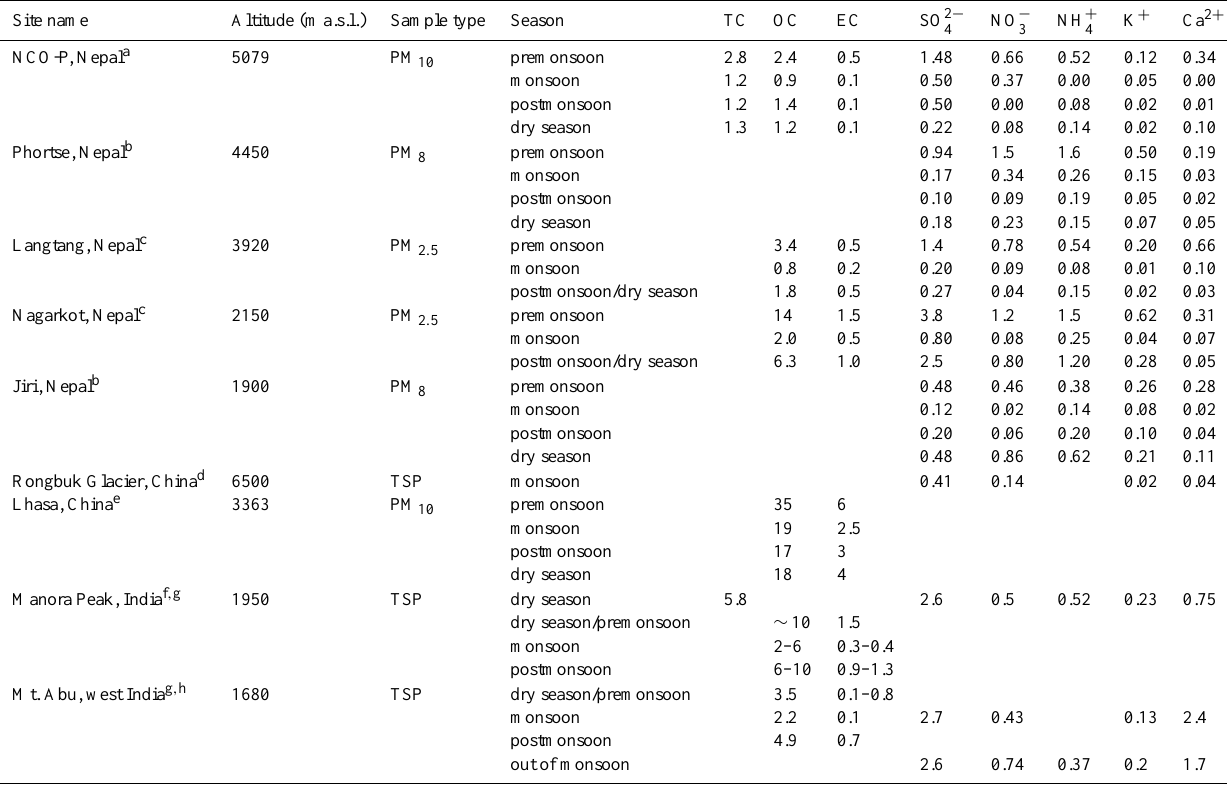
Table 4a. Concentrations of main aerosol chemical species at NCO-P compared to other mountain stations in Nepal, China and India. Data are provided in µg scm − 1 (standard cubic meters). a This study; b Shrestha et al., 2000; c Carrico et al., 2003; d Ming et al., 2007; e Zhang et al., 2008; f Rengarajan et al., 2007; g Ram et al., 2008; h Rastogi and Sarin, 2005.